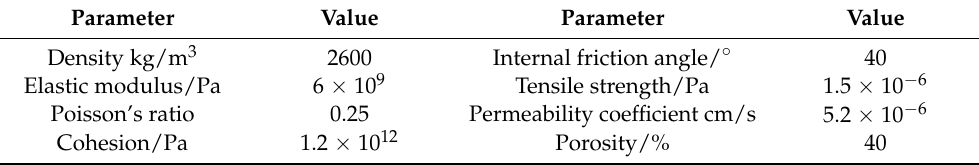
Table 1. Computation parameters of the surrounding rock of the simulated tunnel